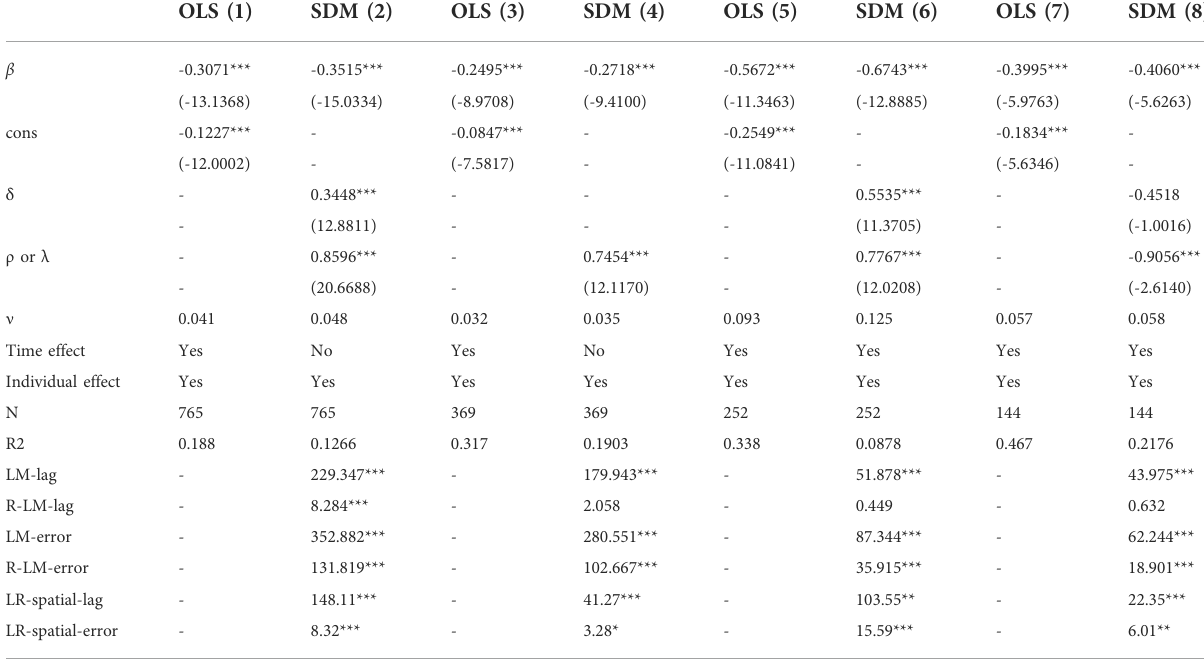
TABLE 6 Results of absolute beta convergence